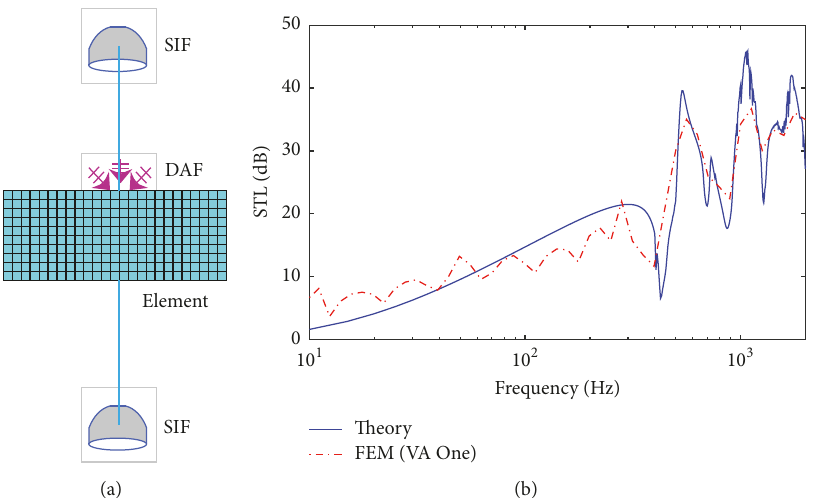
Figure 9: Comparison of the theoretical prediction values and simulation results for the orthogonally rib-stiffened sandwich structure with no shunt piezoelectric patches: (a) FE model and (b) STLs.